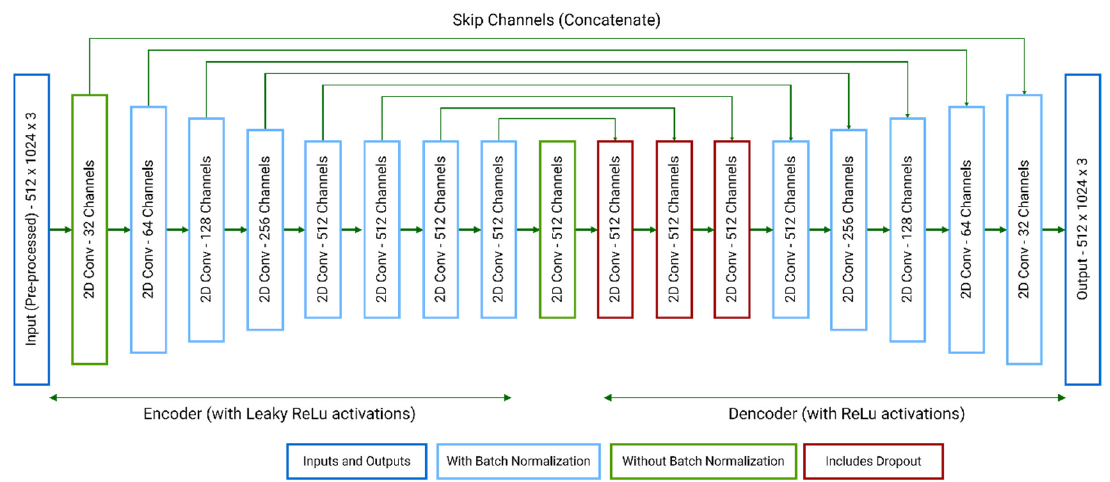
Figure 14. The generator network architecture used in SpecToPoseNet .